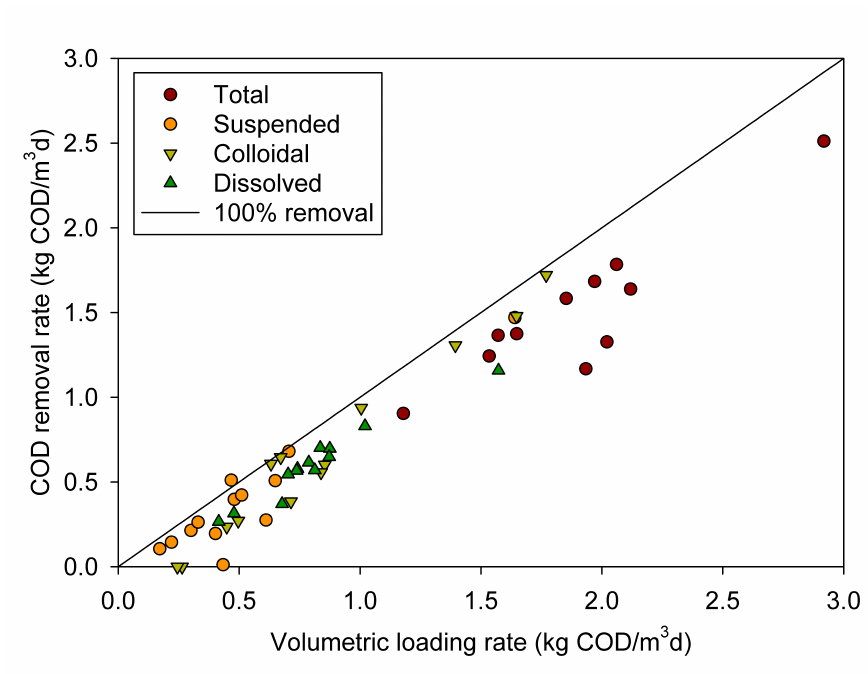
Figure 3. COD removal rate vs. volumetric loading rate in